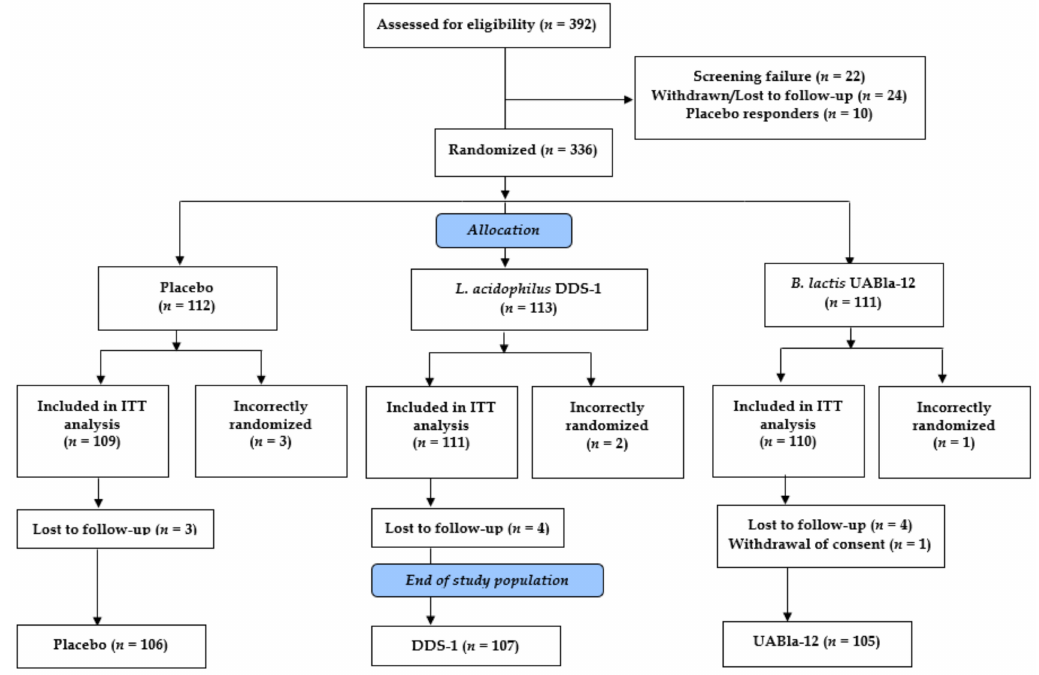
Figure 1. Participant flow chart. ITT: